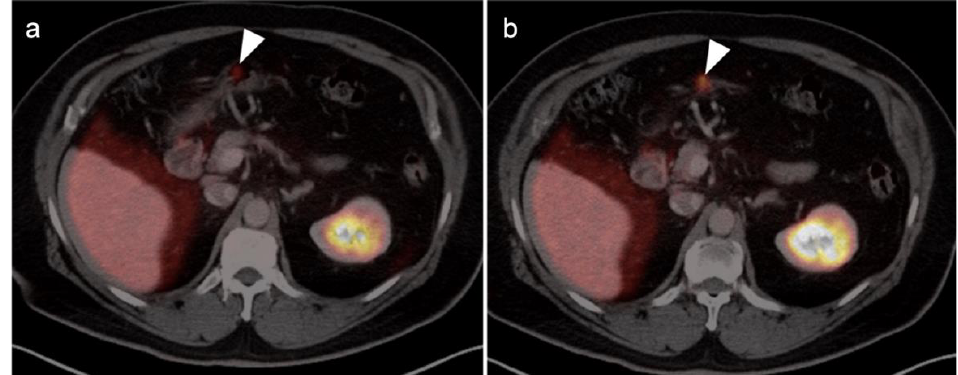
Figure 36. [ 18 F]-PSMA PET-CT demonstrates tiny focus of intense activity in the wall of the stomach ( a , b , white arrows), shown by subsequent endoscopic biopsy to be a small GIST tumor.